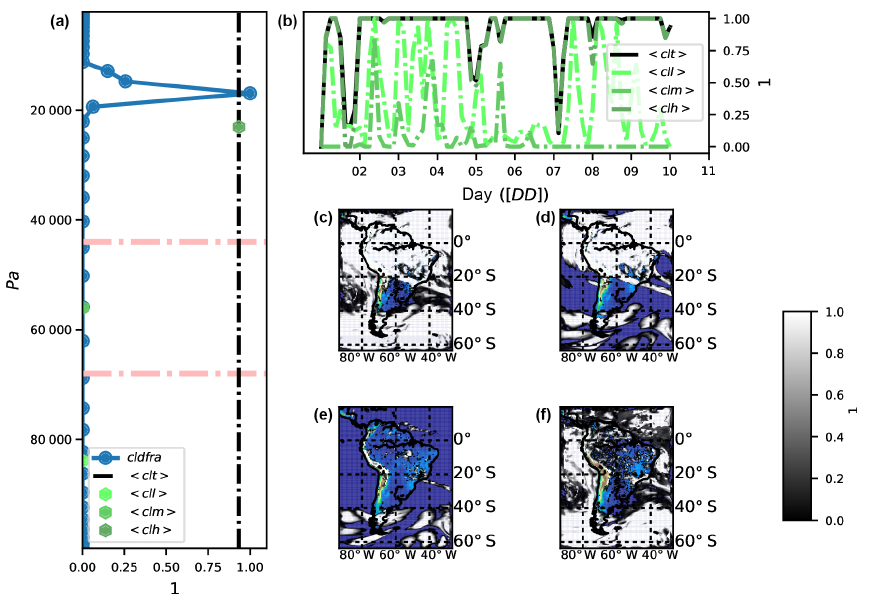
Figure 4. Vertical distribution of cloud fraction and the different cloud layers on 9 December 2012 at 15:00UTC at 62 ◦ 4 (cid:48) 38.00 (cid:48)(cid:48) S, 4 ◦ 58 (cid:48) 55.51 (cid:48)(cid:48) W (a) : cloud fraction (cldfra, full circles with line in blue), mean total cloud fraction (clt, vertical dashed line), mean low- level cloud fraction (cll p ≥ 680hPa, dark green hexagon), mean mid-level cloud fraction (clm 680 < p ≥ 440hPa, green hexagon), and mean high-level cloud fraction (clh p < 440hPa, clear green hexagon). Temporal evolution of cloud layers at the given point (b) . Map of clt with colored topography beneath to show cloud extent (c) ; map of clh (d) , map of clm (e) , and map of cll (f)